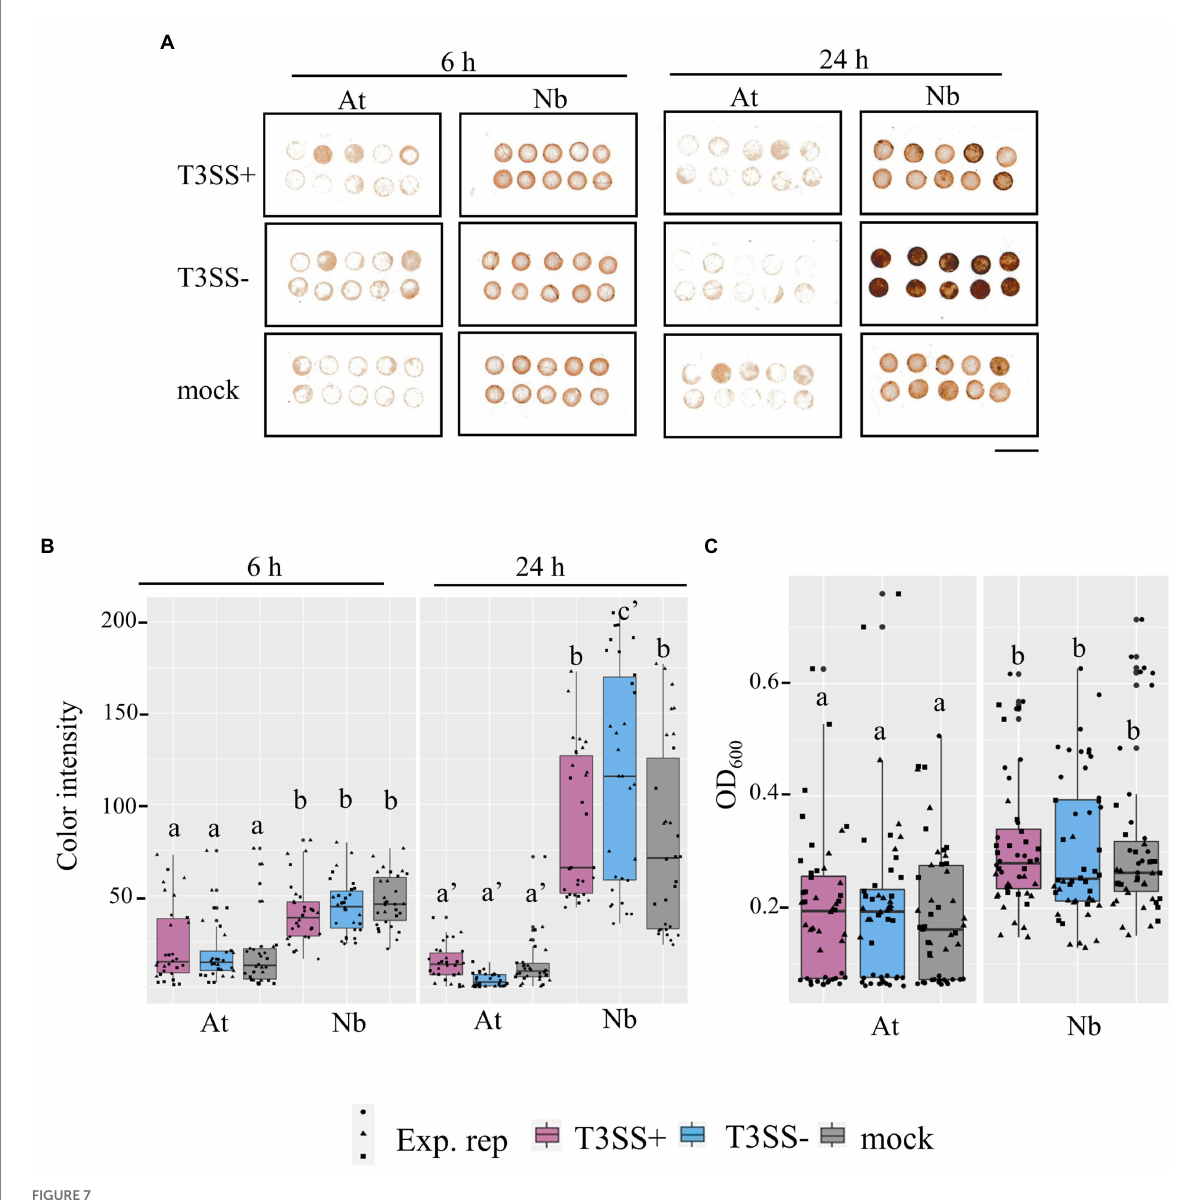
FIGURE 7 Evidence for higher basal ROS in N. benthamiana levels compared to A. thaliana leaves. (A,B) in situ H 2 O 2 in N. benthamiana and A. thaliana inoculated with P. syringae ( Pto ) with (T3SS+) and without (T3SS − ) a functional Type III Secretion System. The detected H 2 O 2 level within inoculated tissues of N. benthamiana (Nb) and A. thaliana (At) were measured with DAB staining at both an earlier time point (6 h) and later time point (24 h). T3SS+ strains, Pto and Pto ∆ hopQ, were used in A. thaliana and N. benthamiana , respectively. Pto ∆ hrcC was used as T3SS − treatment for both plants. Whole leaves were syringe-infiltrated with bacterial suspension (1 × 10 7 CFU mL − 1 for A. thaliana and 1 × 10 6 CFU mL − 1 for N. benthamiana ) or 0.25 mm